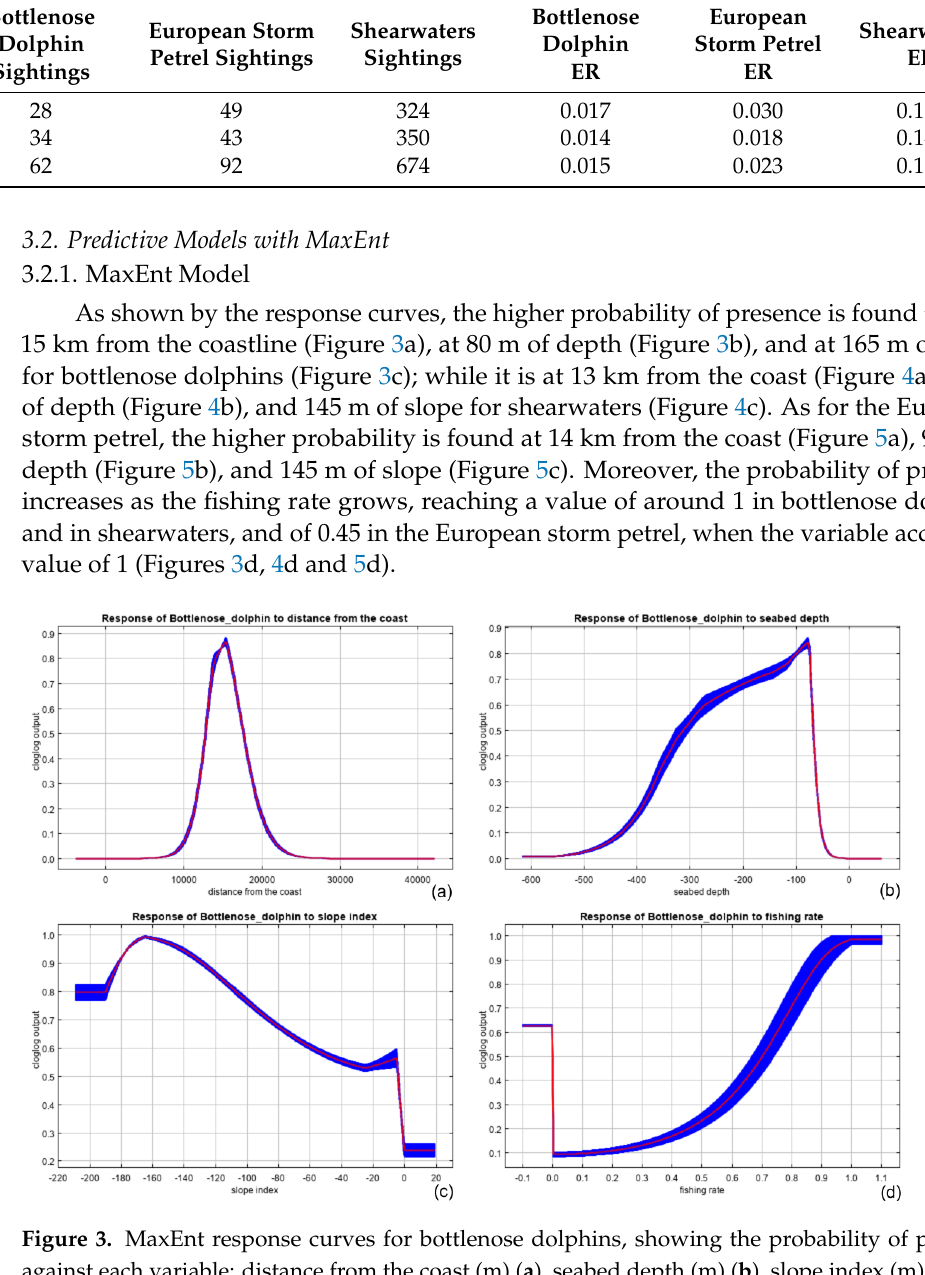
against each variable: distance from the coast (m) ( a ), seabed depth (m) ( b ), slope index (m) ( c ), and